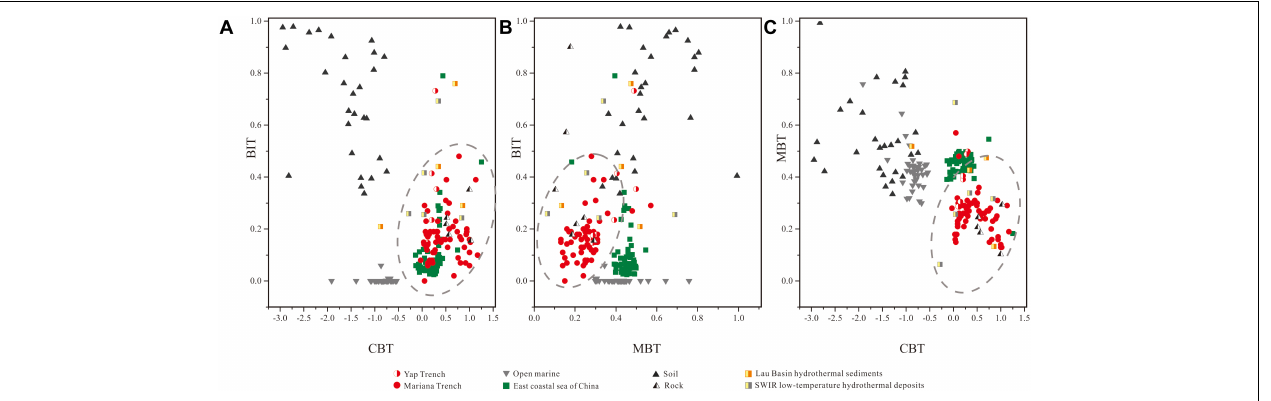
FIGURE 6 | The interrelation between the BIT, MBT and CBT in sediments. (A) BIT and CBT. (B) BIT and MBT. (C) MBT and CBT. The sources of data used in the Figure are as follows: open marine data containing particles and surface sediments from NW Pacific (Yamamoto et al., 2016); lake data containing particulates and surface sediments from 47 European lakes (Blaga et al., 2009); coastal sediment data containing surface sediments from Gulf of Lions (Kim et al., 2010) and the east coastal sea of China (Lü et al., 2014); soil data containing soil samples from 6 province in eastern China (Wu, 2014); data on hydrothermal sediments (Hu et al., 2012); data on low-temperature hydrothermal deposits (Pan et al., 2016).